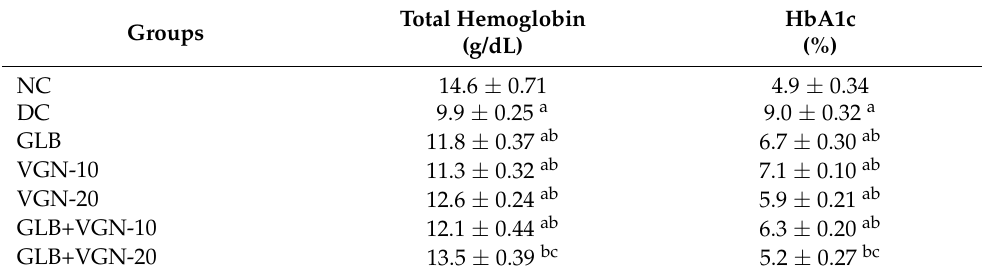
Table 3. Effect of GLB, VGN and their combinations on Hb and HbA1c levels in blood of STZ- induced